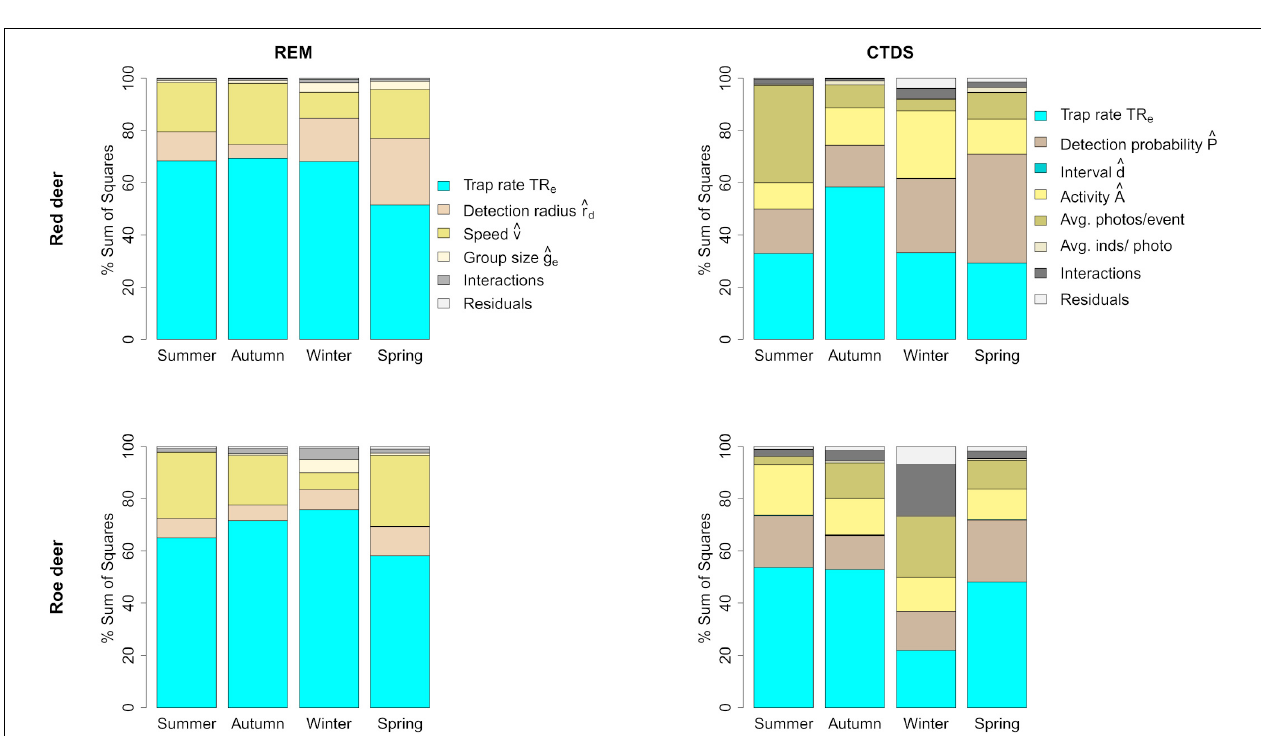
FIGURE 7 | Number of photo series per event for red deer and roe deer, classified by reaction to the camera trap: neutral = the event contains at least one photo series of an animal moving its head to face the camera trap or of an animal looking directly at the camera trap for several photos; attracted = the event contains at least one photo series with an animal moving towards the camera trap, following a neutral reaction; alarmed = the event contains at least one photo series of an animal quickly moving away from the camera trap after a neutral reaction, also after an initial attraction. The percentage of each subgroup in the total number of events n is indicated beneath each box (25 red deer events and 2 roe deer events had > 20 photo series and are not shown).